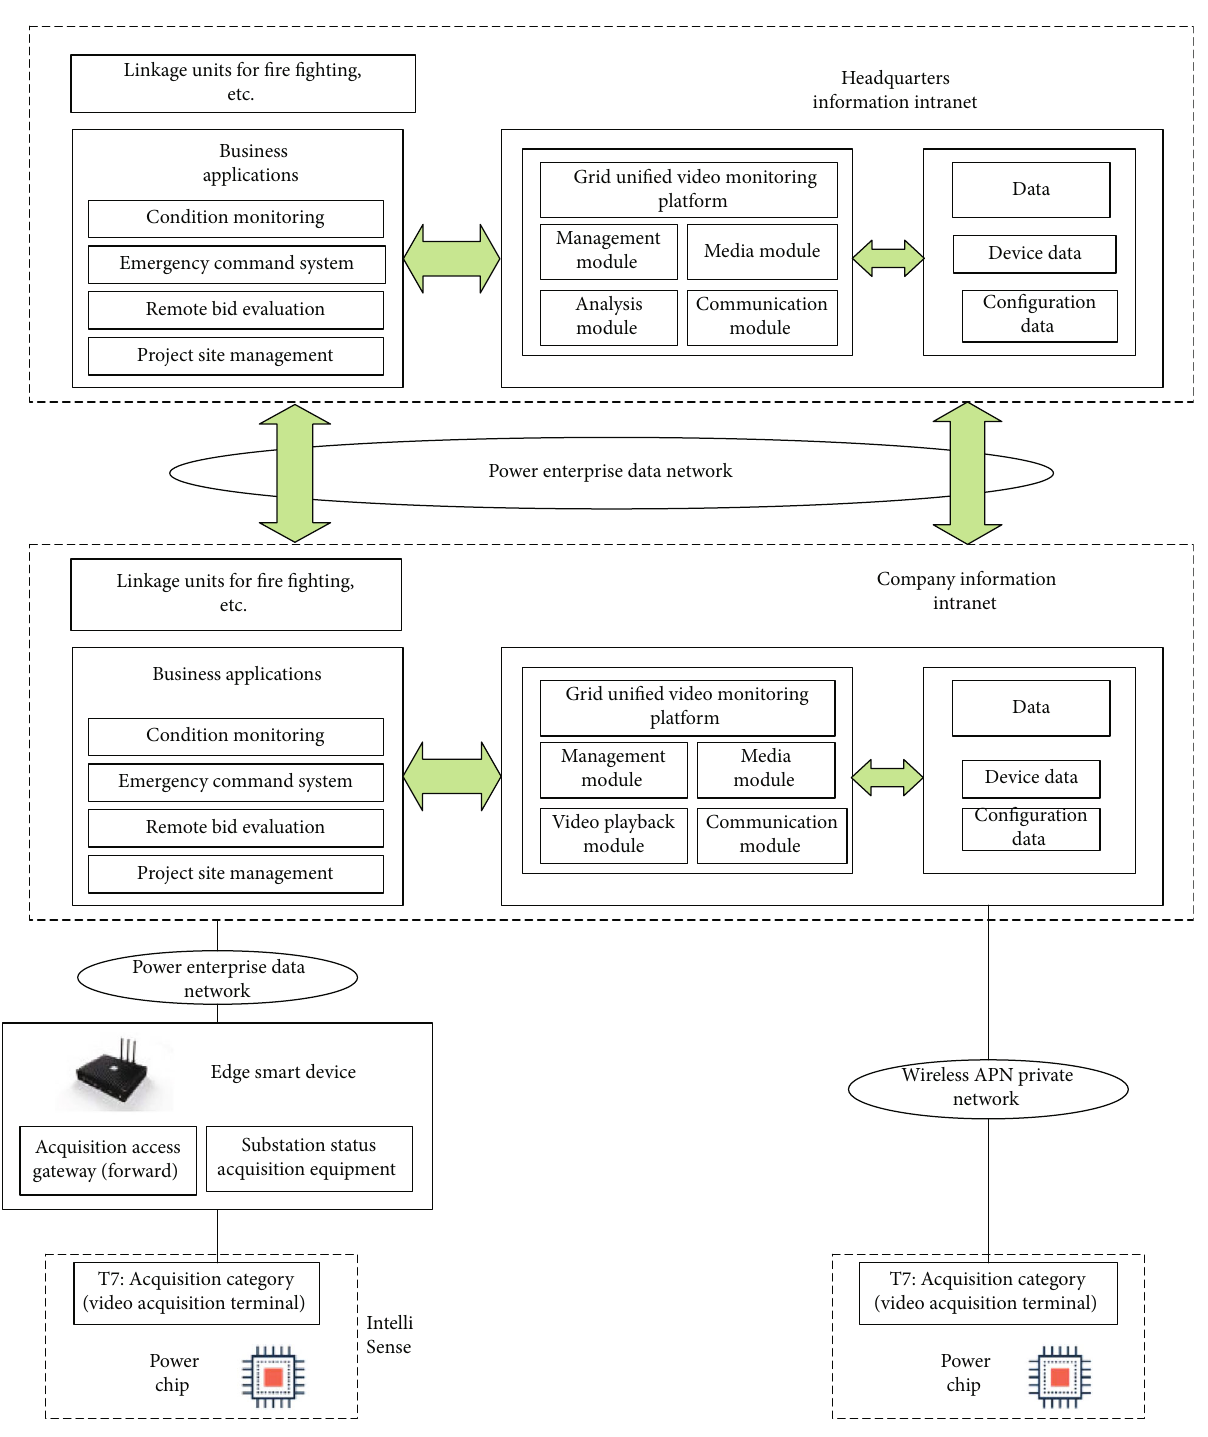
Figure 4: Topology diagram of uni fi ed video monitoring platform for power grid based on AI